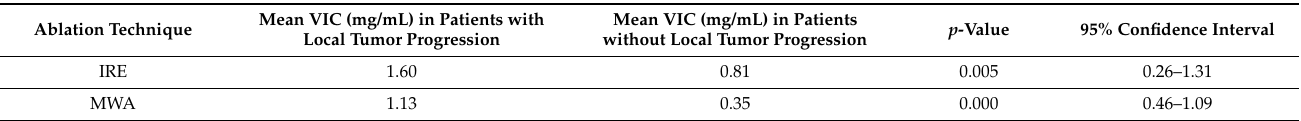
Table 3. VIC of the peripheral ablation area in patients with and without local tumor progression; results of the t-test for independent samples.